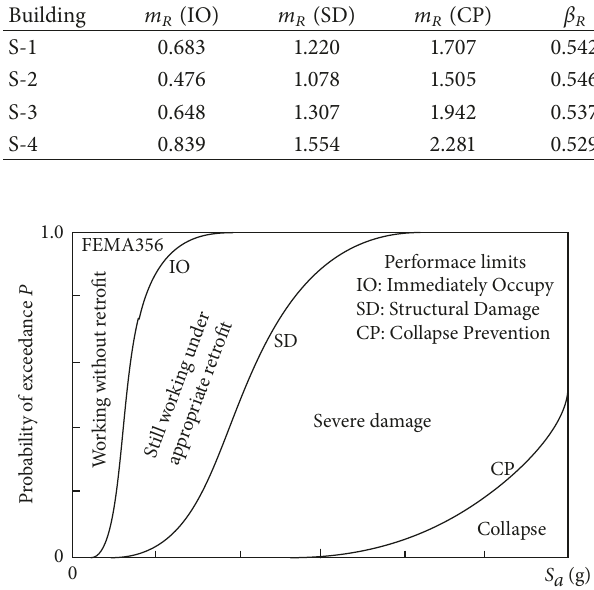
Figure 10: Seismic demands and regression curve of the building S-1.